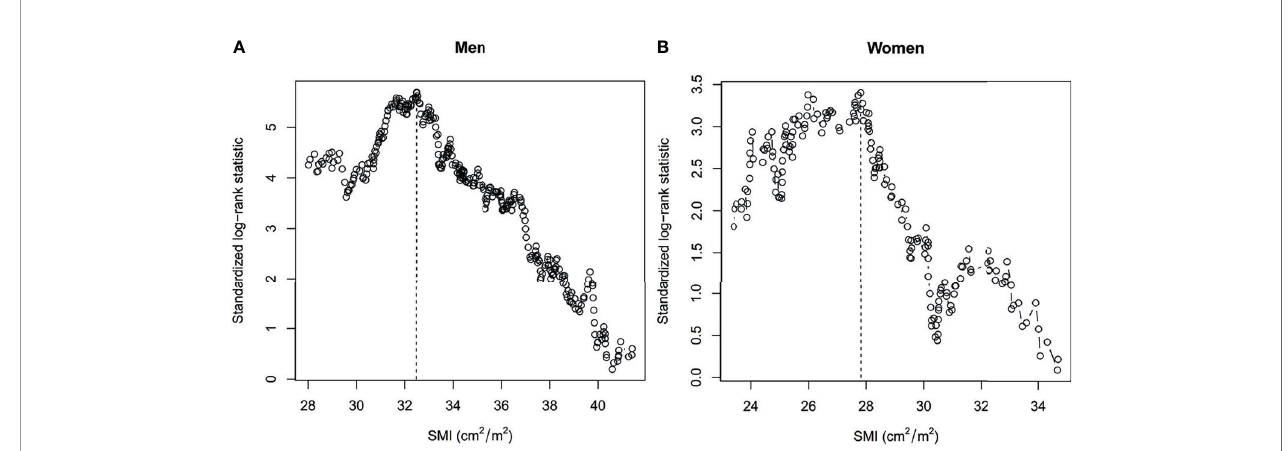
FIGURE 2 | Cut-off Values of the Skeletal Mass Index at the 12 th Thoracic Vertebra Level (T12 SMI) in (A) Men and (B) Women Using Maximally Selected Rank Statistics. Dashed lines show the cut-off values. SMI, skeletal mass